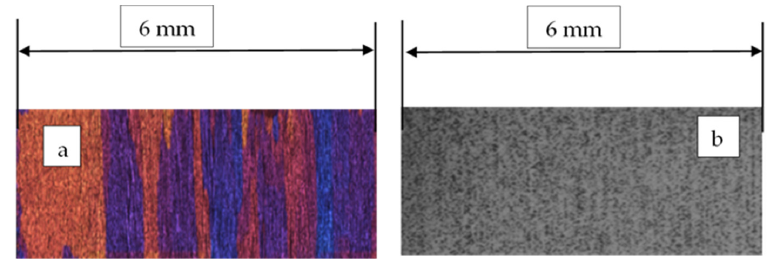
Figure 6. ( a ) Coarsened α grains in the non-melted part; ( b ) very fine Si particles in it. Part 1